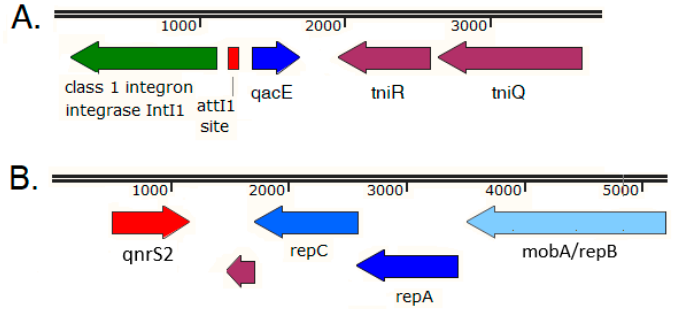
Figure 4. The immediate genetic environment of acquired resistance genes on selected carp intesti- nal metagenomics contigs. The 3754 bp contig carrying the qacE resistance determinant to quater- nary ammonium compounds ( A ), and the 5852 bp carp contig harboring the qnrS2 quinolone re- sistance determinant ( B